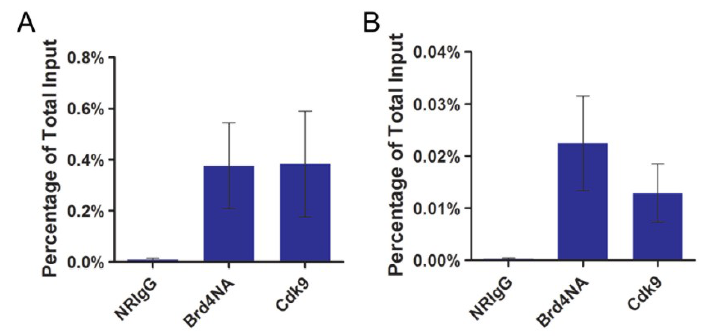
Figure 2. P-TEFb is recruited to the papillomavirus genome. ( A ) H2 cells were subjected to ChIP assay using normal rabbit IgG (NRIgG), Brd4NA antibody, or anti-Cdk9 antibody. ChIP samples were analyzed by qPCR using primers targeting the BPV1 genome; ( B ) W12 (clone 20863) cells were subjected to ChIP assay as in ( A ) and ChIP samples were analyzed by qPCR using primers targeting the HPV16 genome. For both ( A ) and ( B ),